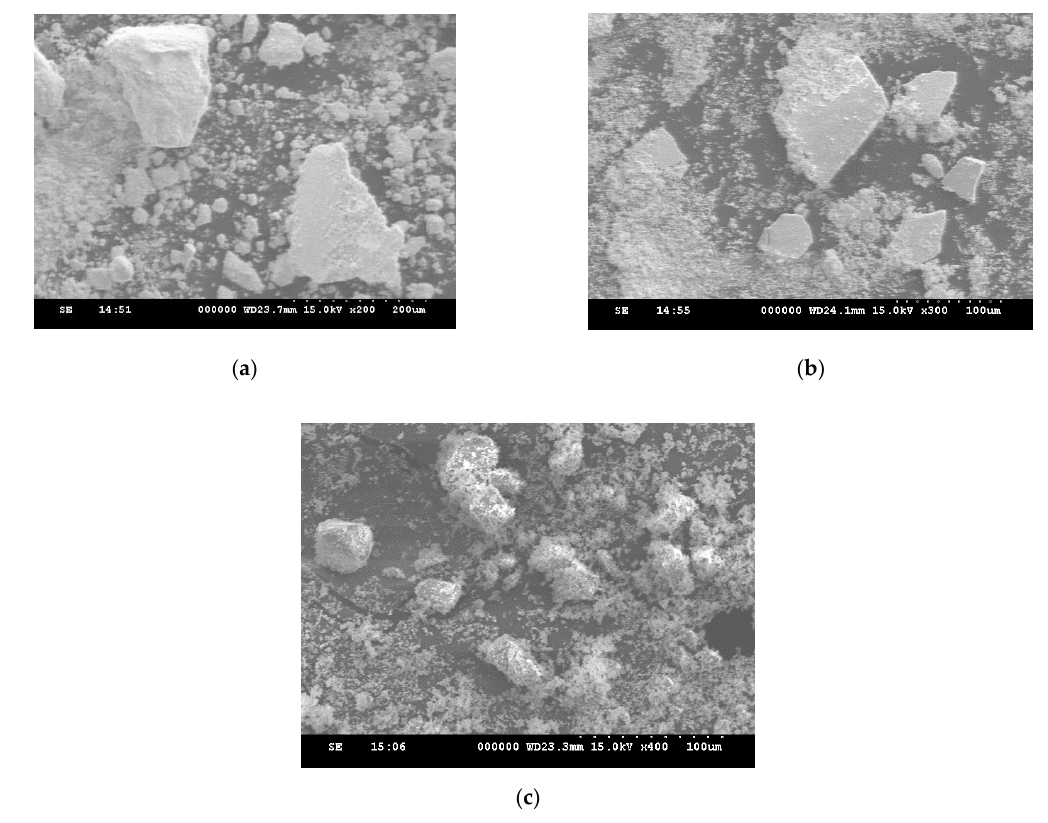
Figure 12. SEM (scanning electron microscopy) images of ( a ) the recovered cerium oxide abrasive, ( b ) the original cerium oxide abrasive, and ( c ) the abrasive – glass polishing waste (experimental conditions of the recovered cerium oxide abrasive: abrasive – glass polishing waste: approximately 1 g; roasting temperature: 450 °C; mass ratio of polishing waste to NaOH: 1:1; roasting time: 30 min;